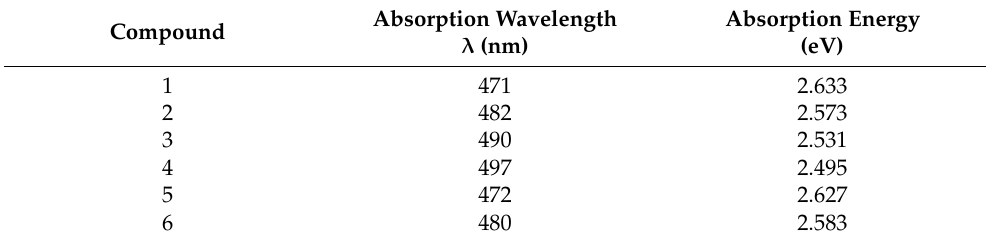
Table 5. Experimental absorption wavelengths and energies of the flavylium dyes.